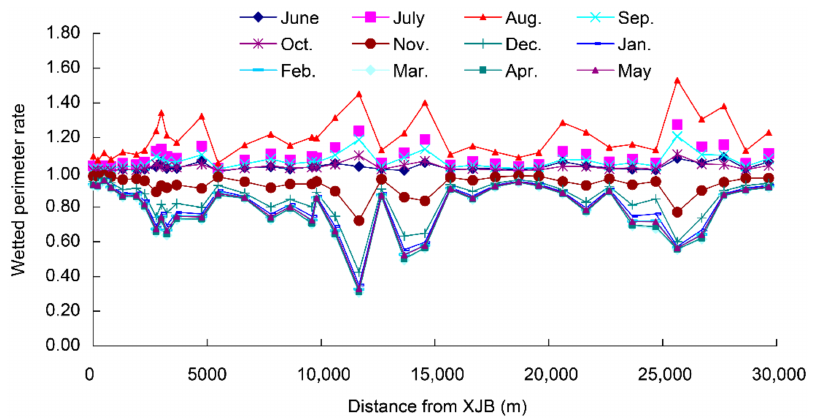
Figure 8. Average water depth for each month during typical dry years in the study area.